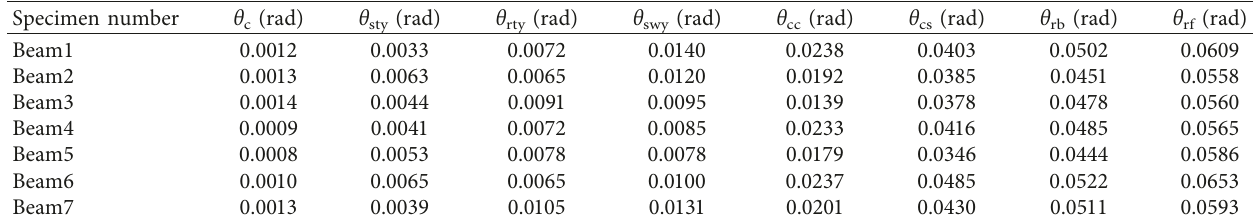
Figure 6: Lateral load-chord rotation hysteretic curves and skeleton curves of specimens. (a) Beam1. (b) Beam2. (c) Beam3. (d) Beam4. (e) Beam5. (f) Beam6. (g) Beam7. Table 4: Chord rotation of specimens at the individual damage characteristic